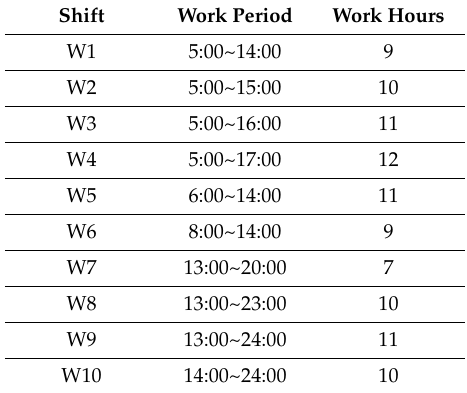
Table 5. Work shifts and periods.